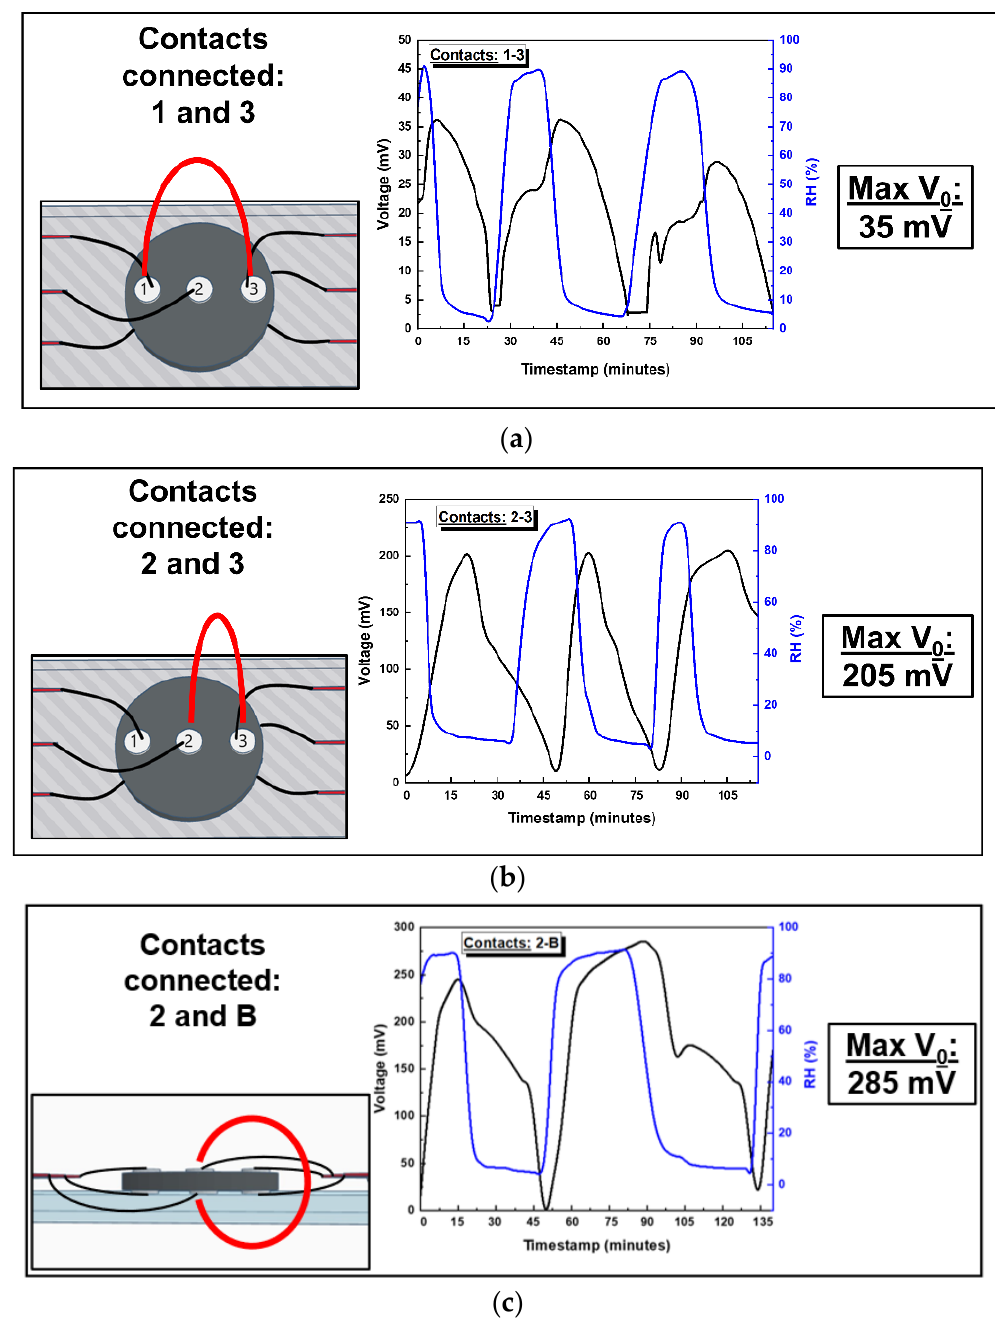
Figure 4. Moisture-induced voltage (V o ) generated by the GOP-1 device as a function of the relative humidity (RH) within the test chamber for ( a ) horizontal configuration 1 – 3; ( b ) horizontal configuration 2 – 3; ( c ) vertical configuration 2-B.